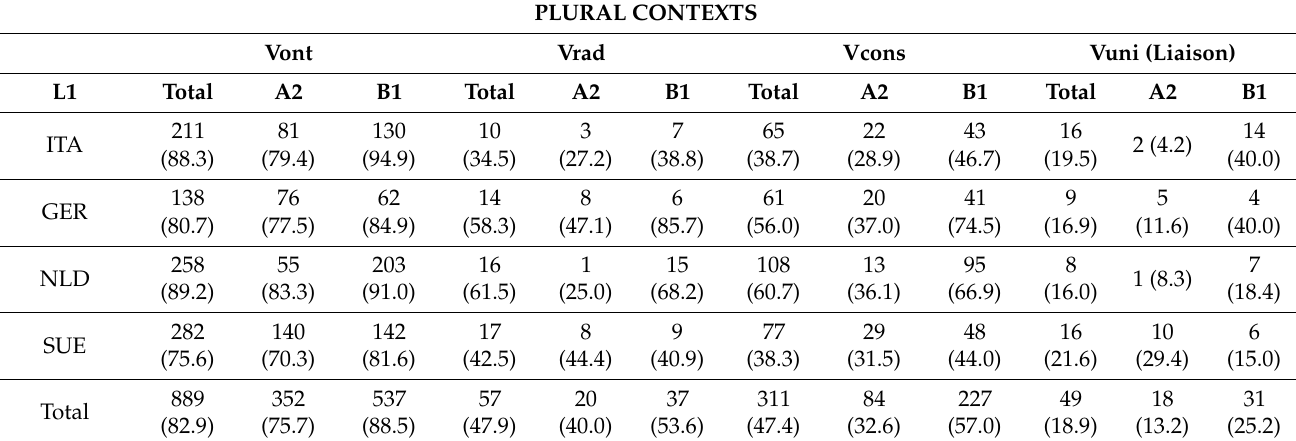
Table 7. Number of correctly agreeing verb forms in plural contexts in the different agreement patterns Vont, Vrad , Vcons and Vuni (liaison) (proportions within